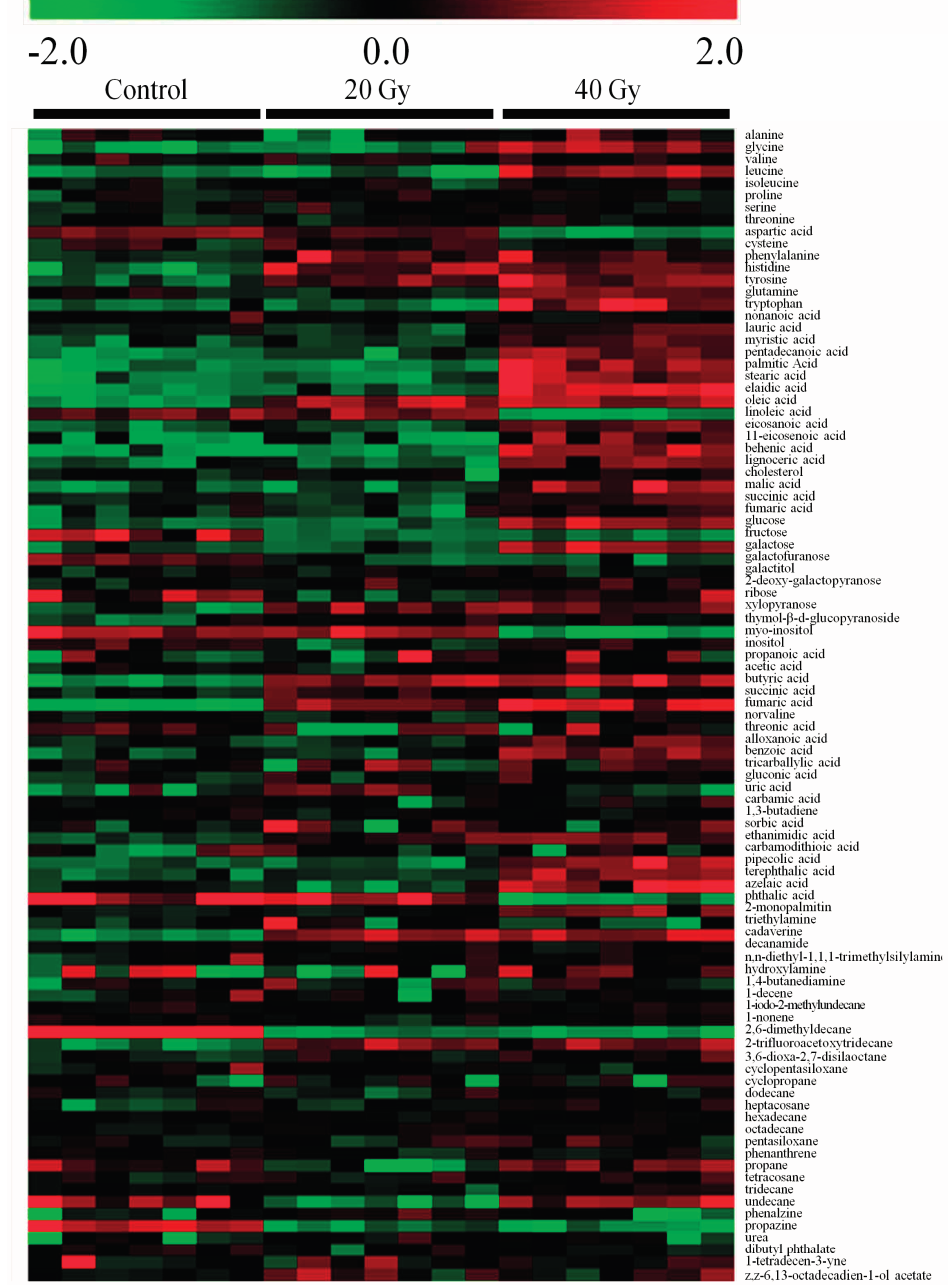
Figure 2. Heat map representation of the unsupervised hierarchical clustering of 98 metabolites across the non-irradiated and irradiated samples. The sample classes are indicated by the black bars (control = non-irradiated samples, 20 Gy = 20-Gy-irradiated samples, and 40 Gy = 40-Gy-irradiated samples). The columns represent the individual tissue samples, and the rows refer to distinct metabolites. Increases in the intensities of red and green indicate elevations and decreases, respectively, in the levels of a metabolite relative to the median metabolite